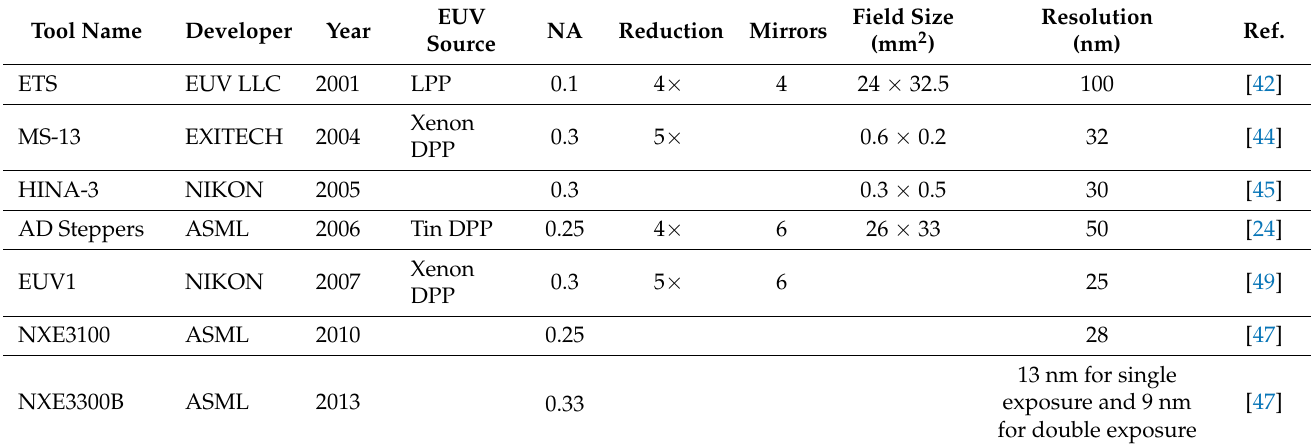
Table 1. Advancements in exposure tool of